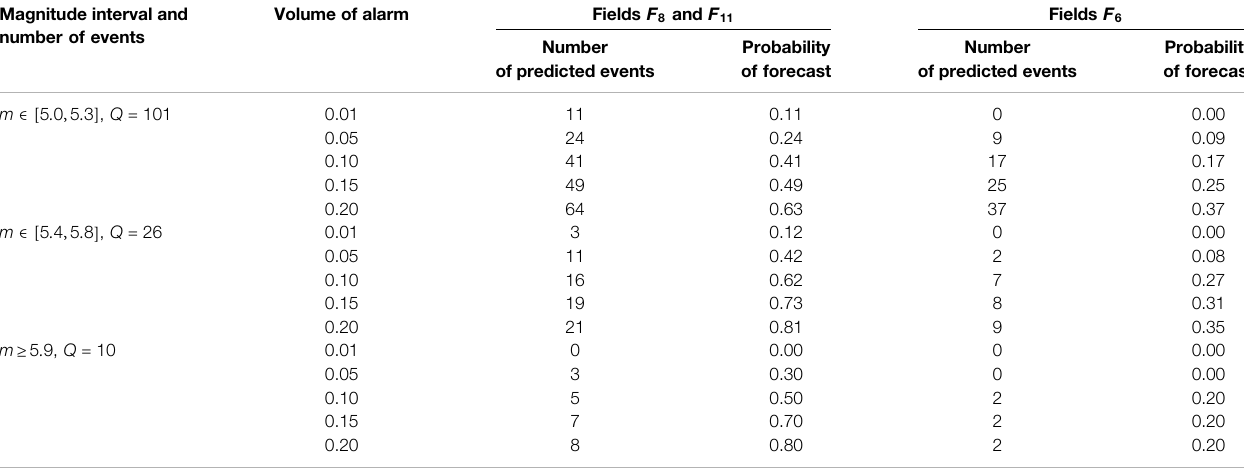
TABLE 2 | The Aegean Region: probabilities of forecasting the earthquakes in the magnitude intervals m ∈ [ 5 . 0 , 5 . 3 ] , m ∈ [ 5 . 4 , 5 . 8 ] , m ≥ 5 . 9. Magnitude interval and number of events